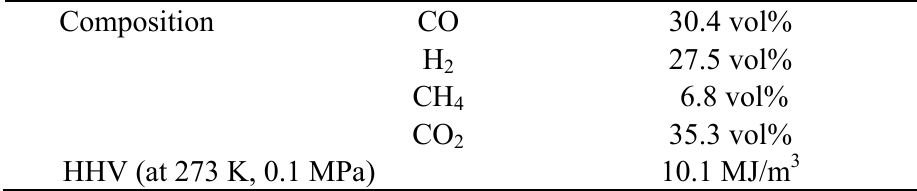
Table 6. Typical conditions of supplied fuel.